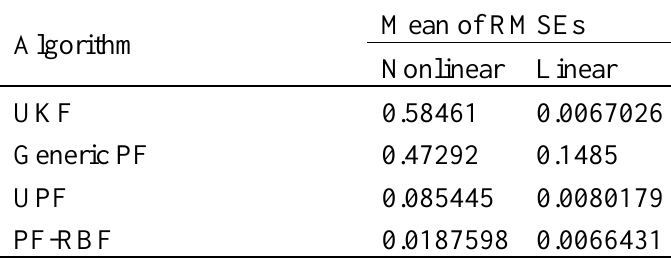
Table 1. Estimated results generated by each algorithm where the mean and variance of RMSEs are calculated over 100 independent runs. The particle number is